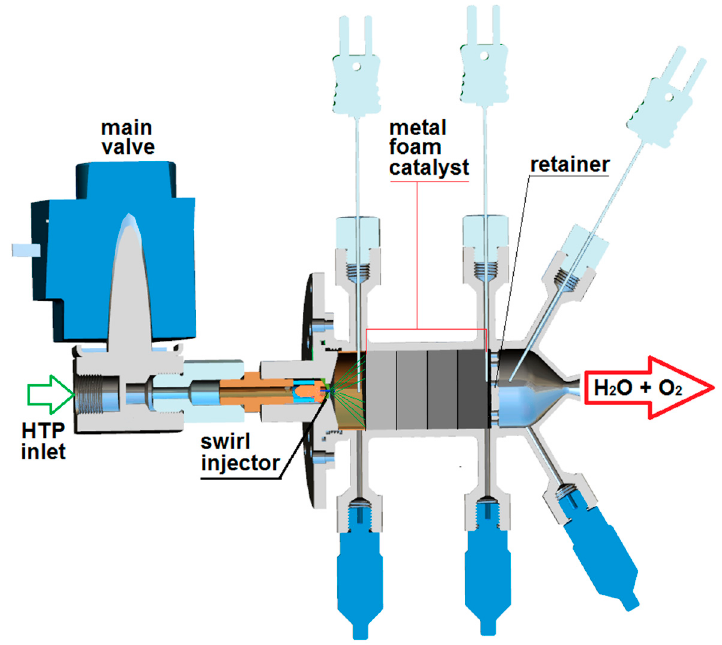
Figure 4. The thruster-like test setup Figure 1. The thruster-like test setup configuration